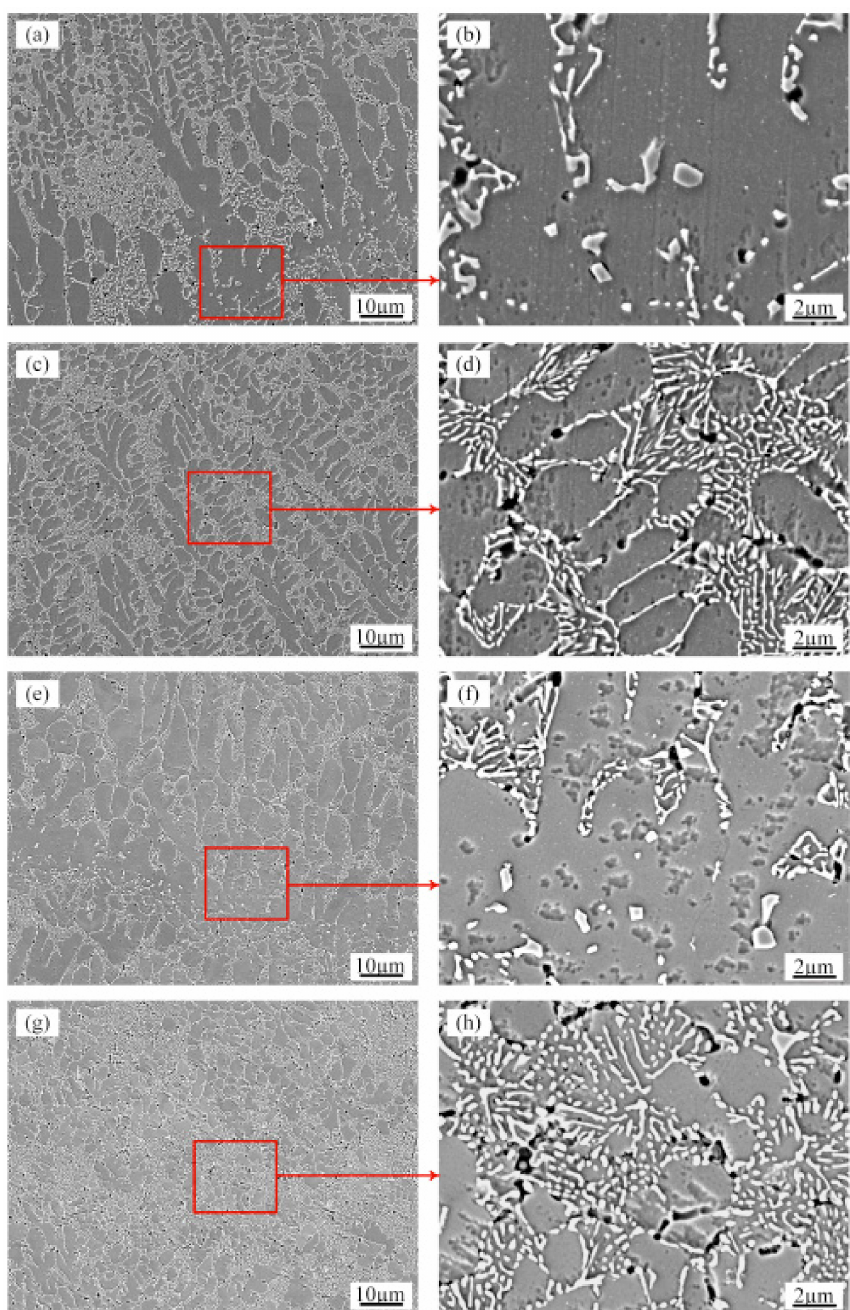
Figure 7. SEM micrographs showing the morphology of Si in the ( a , b ) Boundary of the molten pool of the AS samples; ( c , d ) Upper part of the molten pool of the AS samples; ( e , f ) Boundary of the molten pool of the RM samples with ultrasonic vibration; ( g , h ) Upper part of the molten pool of the RM samples with ultrasonic